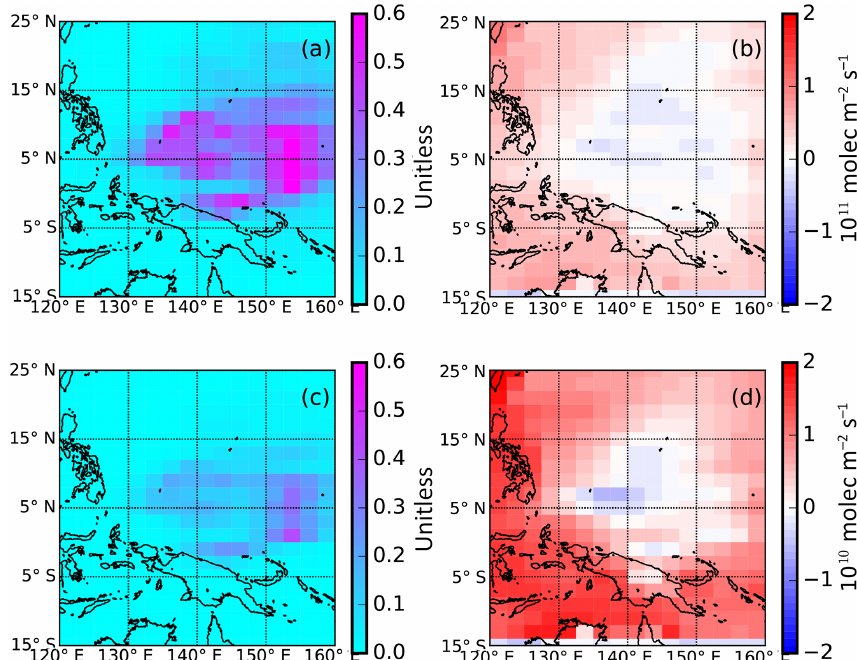
Figure 3. Simulated error reductions (unitless) and a posteriori flux error distributions of CHBr 3 (panels a and b ) and CH 2 Br 2 (panels c and d ) based on the theoretical potential to recover true fluxes using the time and location of CAST and CONTRAST data.